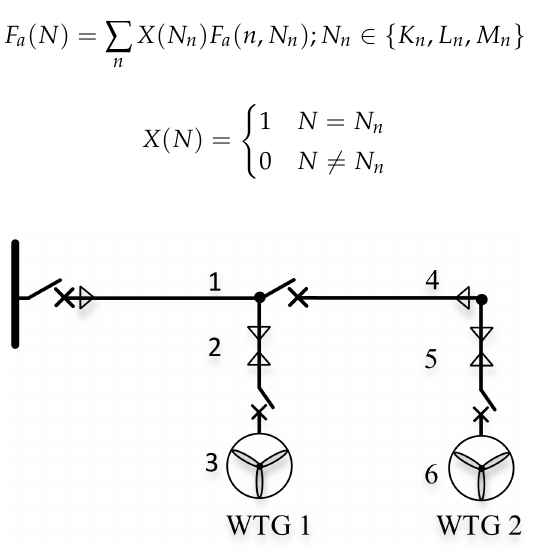
Figure 3. A simplified wind farm electrical system for describing the proposed